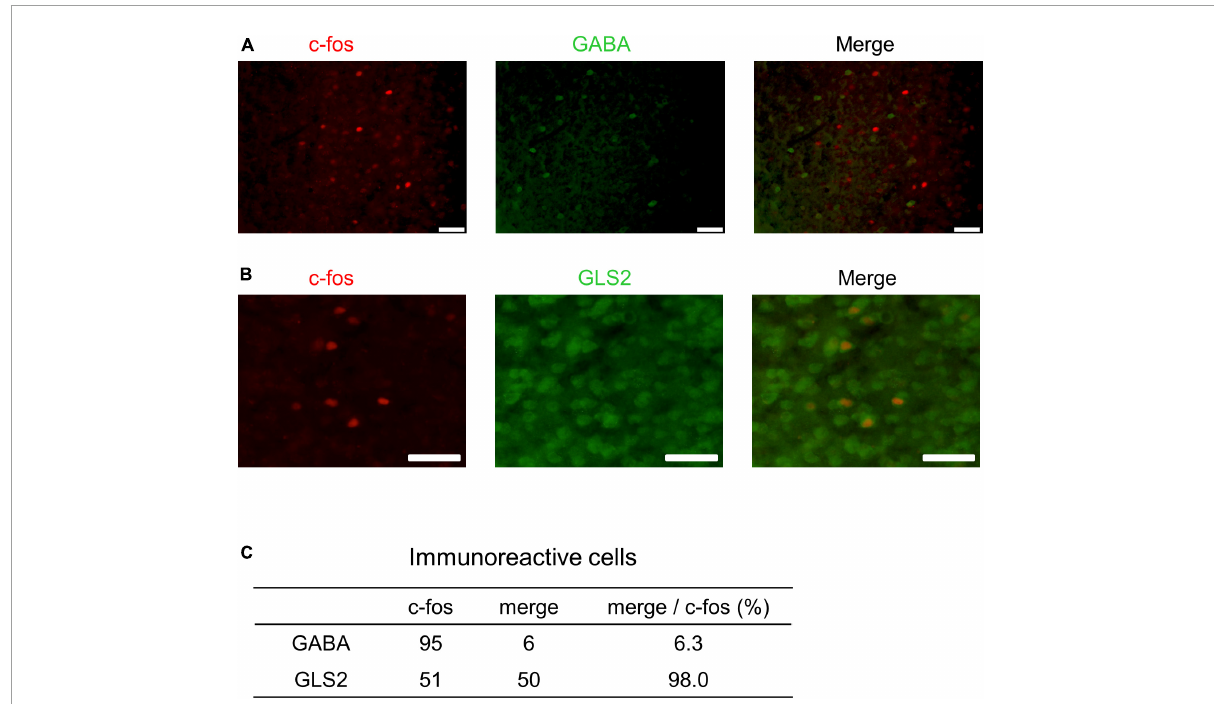
FIGURE8 Double immunohistochemistry of c-fos and markers for excitatory or inhibitory neurons in PrL. (A,B) Representative fluorescent images. c-fos positive cells are shown in red; GABA- or GLS2-positive cells are shown in green. Scale bars indicate 50 µ m. The percentage of double positive cells in the population of c-fos-positive cells is shown in panel (C)